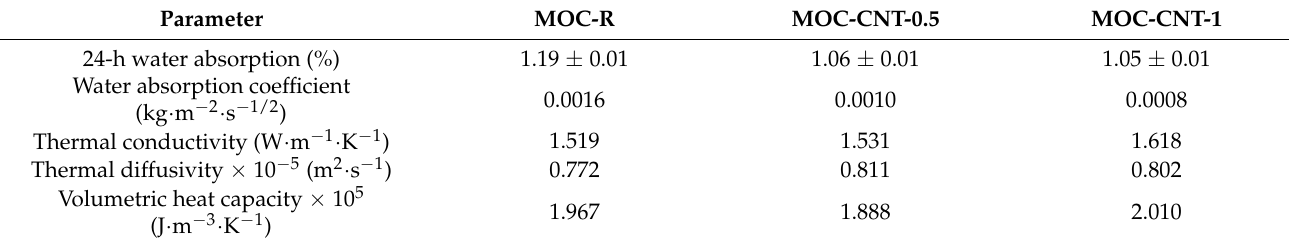
Figure 7. Cumulative pore volume of the investigated composites. Table 3. Hygric and thermal parameters of the tested